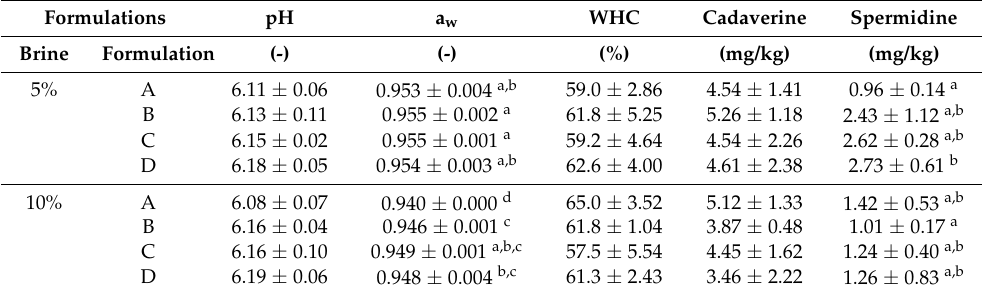
Table 2. pH, water activity (a w ), water holding capacity (WHC) (%) and biogenic amines—cadaverine and spermidine